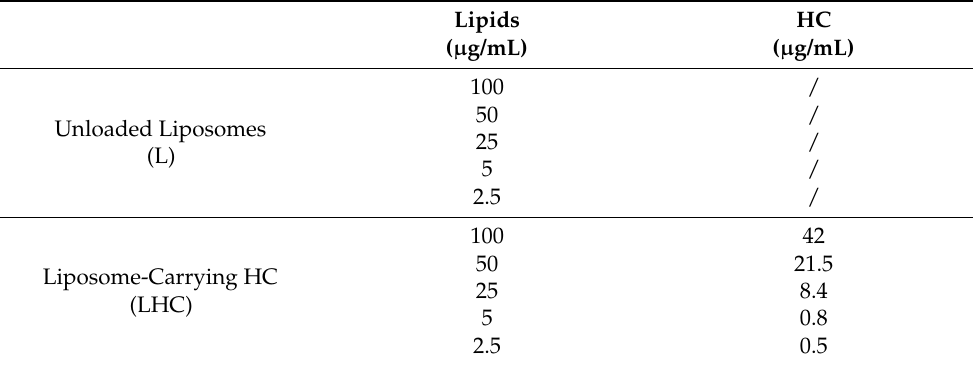
Table 2. Relationship between concentrations of total lipids and HC (calculated on the basis of EE%) in the produced liposomes.